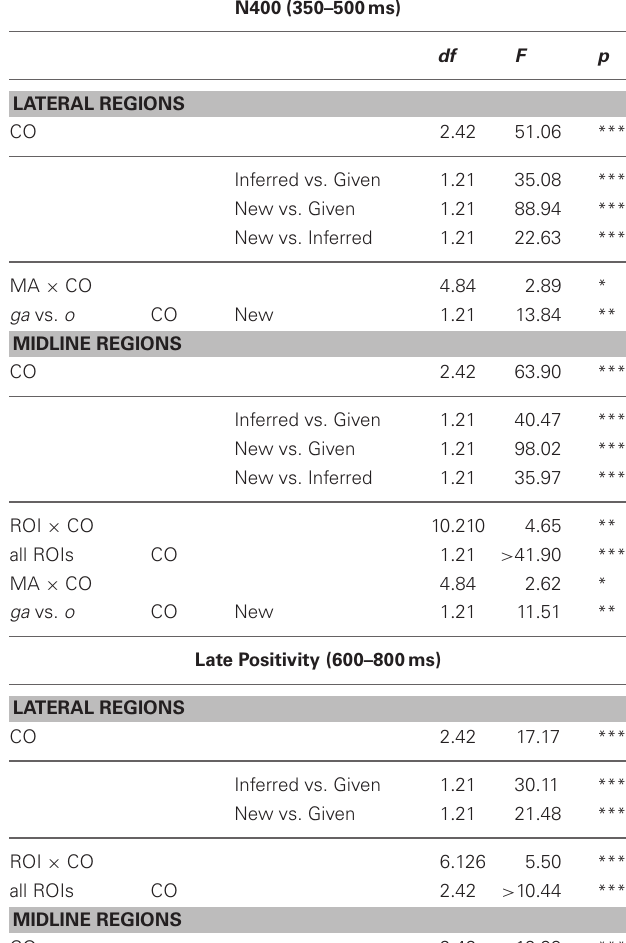
Table 4 | Analysis of variance (ANOVAs) of the mean ERP amplitudes in Experiment